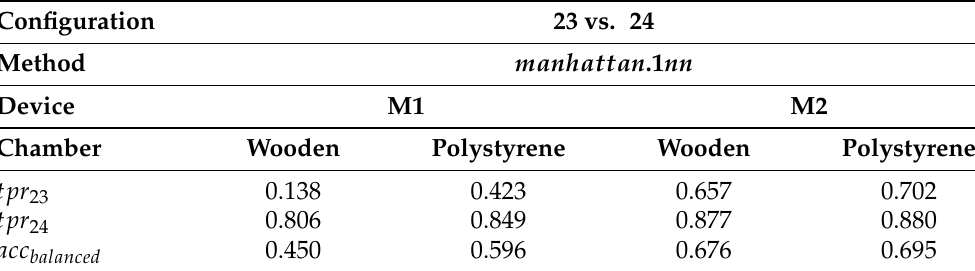
Table 9. The obtained tpr values for class 23 and 24, and acc balanced in validation tests of 5 × MCCV-5 in comparison of 23 vs.24 for manhattan .1 nn test, devices M1 and M2.